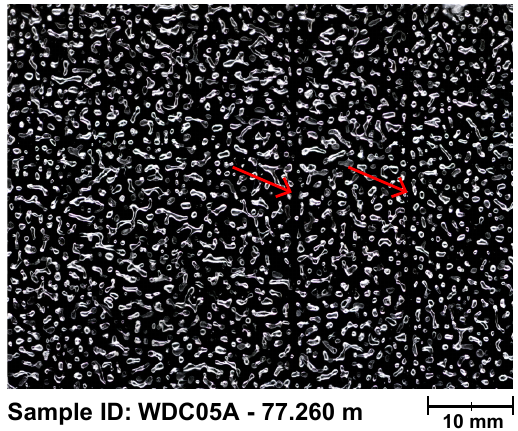
Figure 1. A thick-section image of a sample prepared from a depth of ∼ 77.260m showing two preserved crusts. Both layers are ∼ 1mm thick and appear mostly bubble-free. All bubbles here ap- pear white, with the surrounding ice black. The general elongated shape of the bubbles is due the proximity of this sample to the bub- ble close-off depth at WAIS Divide of ∼ 75m. This sample is from the secondary WDC05A core at the WAIS Divide site. Image mod- ified from Orsi et al. (2015).